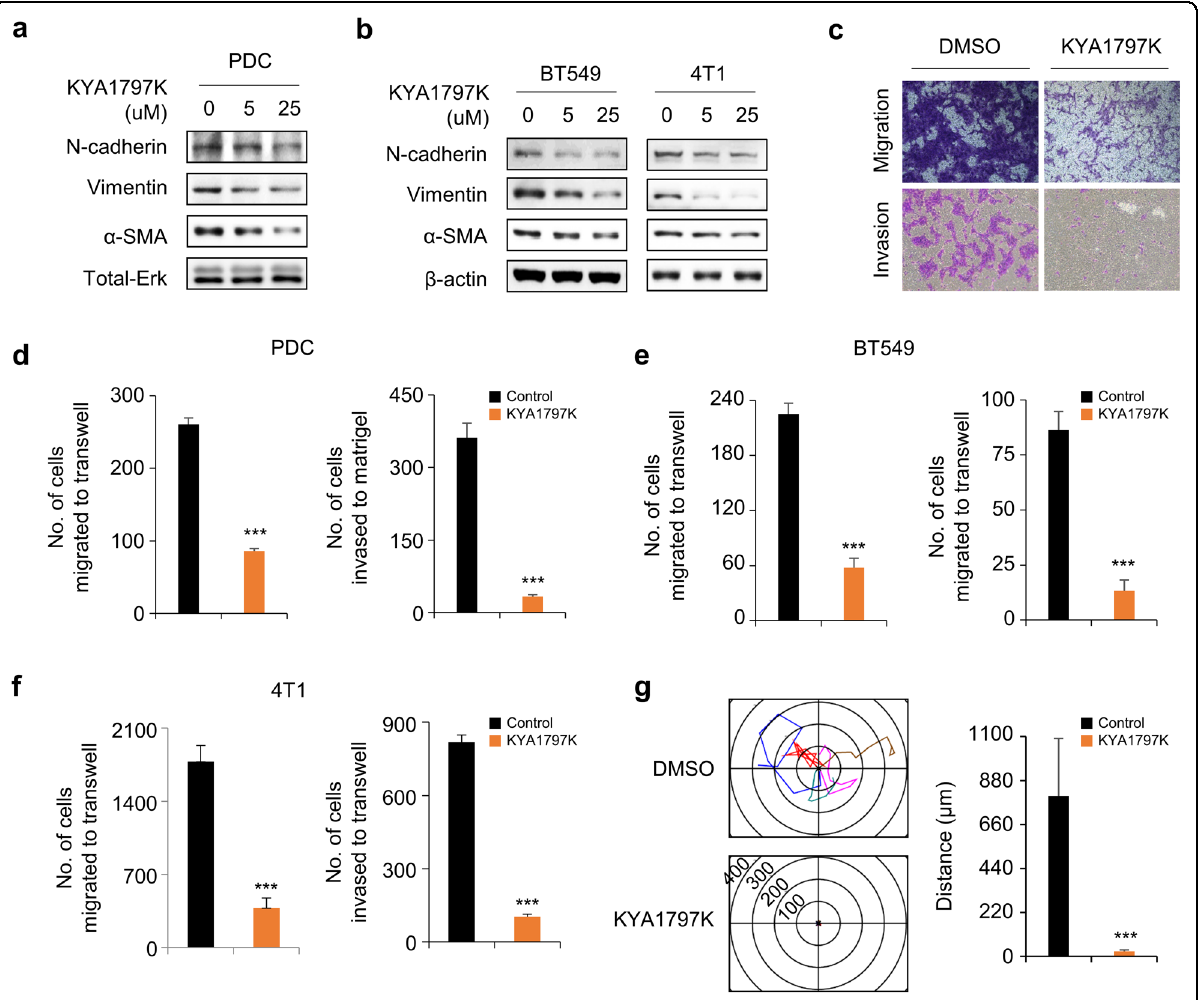
Fig. 3 Inhibitory effects of KYA1797K on migration and invasion in TNBC cells. a , b IB analyses of WCLs from PDCs ( a ) or cell lines ( b ) were performed using indicated antibodies. c – f Migration or invasion assay were performed using noncoated or Matrigel-coated chambers on PDCs or BT549 and 4T1 cells. Migrated or invaded cells were stained with 0.25% crystal violet. The representative images in c were captured with a Nicon TE- 2000U. The number of migrated or invaded cells in PDCs ( d ) or BT549 and 4T1 cells ( e , f ) were quanti fi ed. g Single-cell migratory pattern was monitored using real-time imaging microscopy (Eclipse Ti, Nikon) in PDCs ( n = 5). A collagen coating was applied before seeding the cells. Data values represent the mean ± SEM. * P < 0.05, ** P < 0.005, *** P <